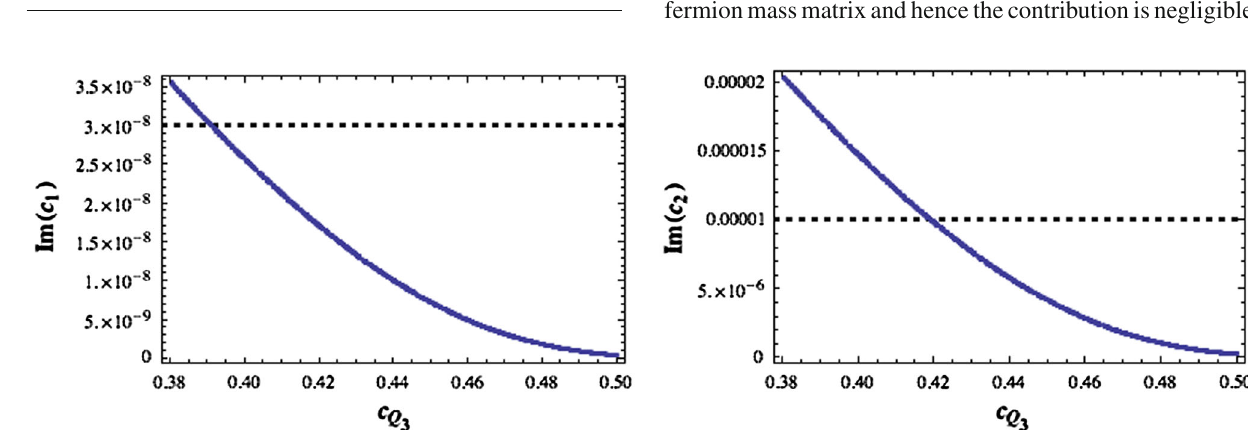
Fig. 2 The Wilson co-efficient c i as a function of c Q